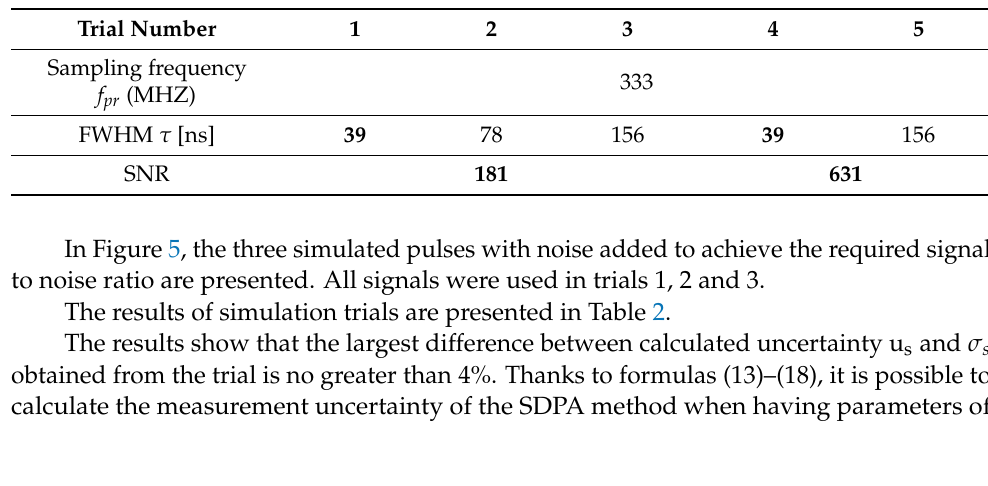
Table 1. Parameters of generated signals used during